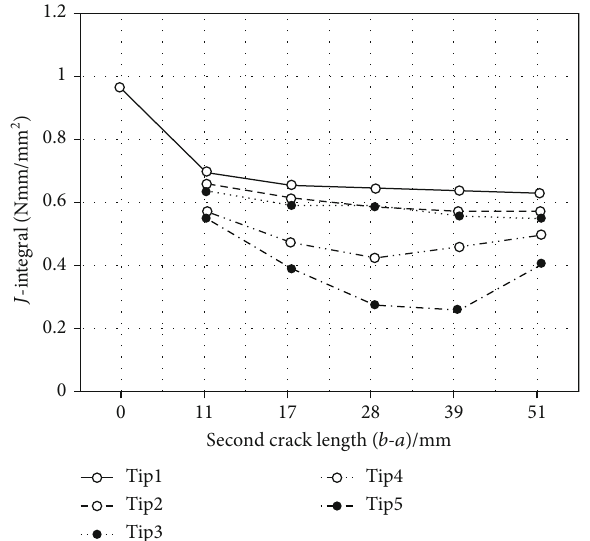
Figure 10: The J -integral variation with the third crack of three collinear insulation